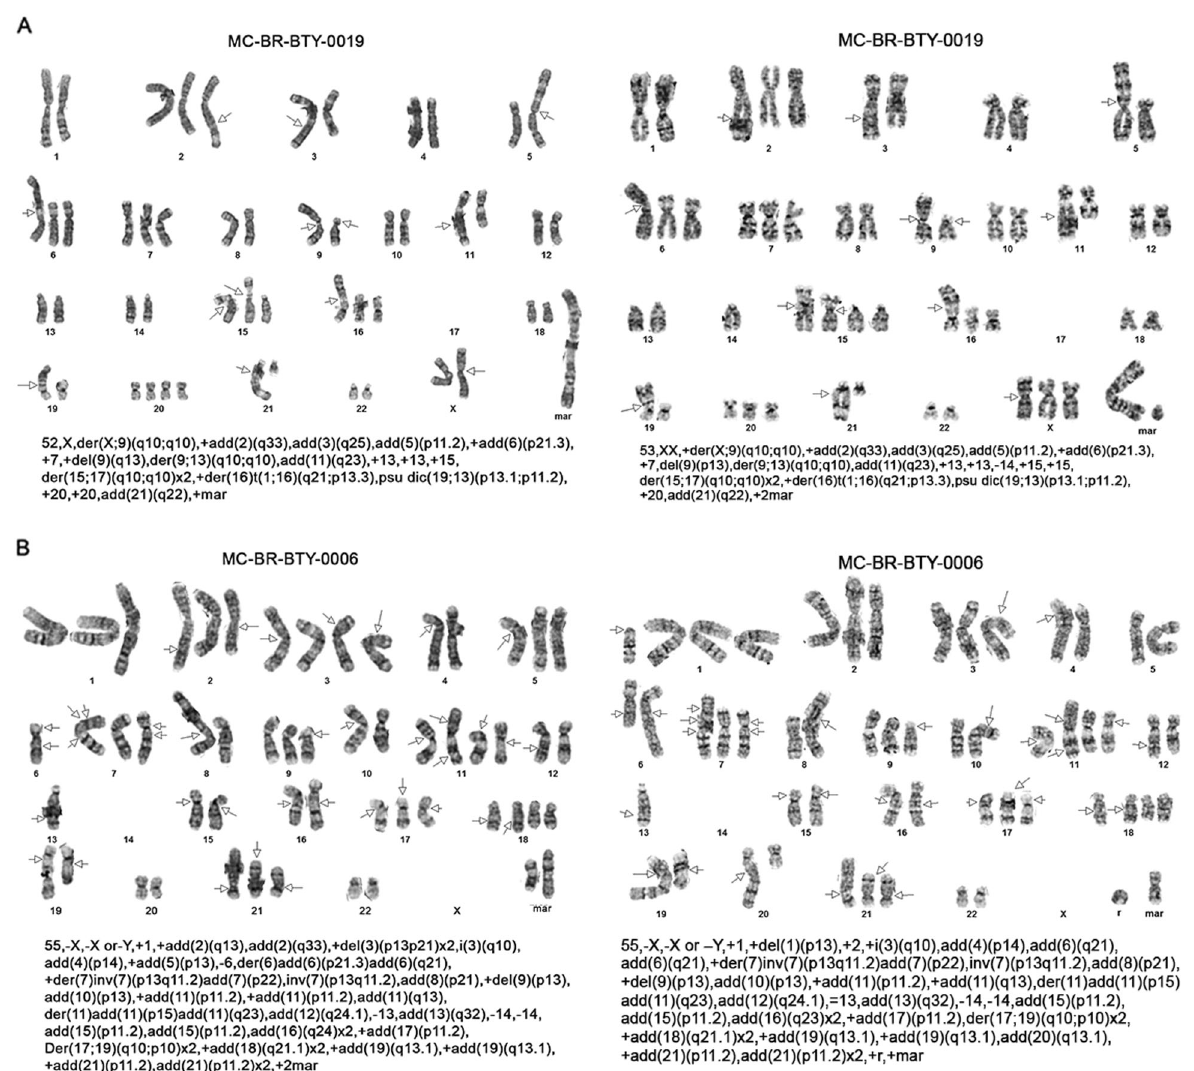
Fig. 2 Two newly established breast cancer cells lines presented massive abnormal karyotypes. A , B Cytogenetics G-band staining of chromosomes is presented and chromosome alteration is described for two cells, MC-BR-BTY-0019 and MC-BR-BTY-0006 cell lines, respectively. Each image is a karyotype of one cell. Text below each karyotype refers to International System for the Human Cytogenetic Nomenclature (ISCN) of the karyotype to address the number of chromosomes observed, the sex chromosome, and the abnormalities observed per chromosome. The arrows indicate breakpoints or